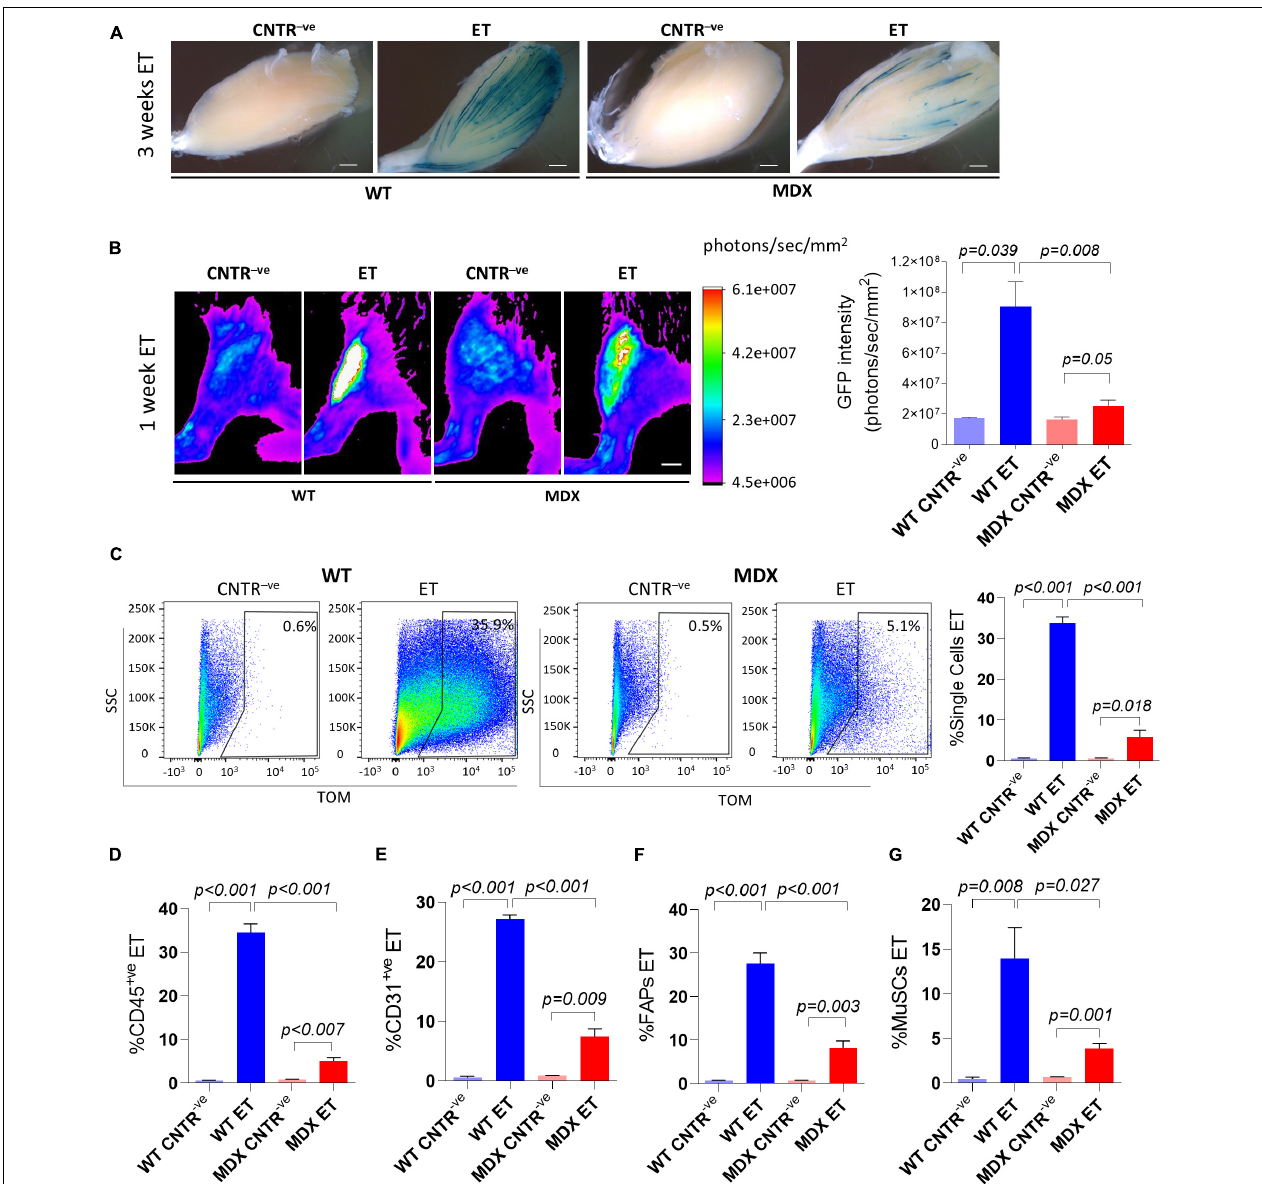
FIGURE 3 | In vivo electroporation of dystrophic muscles. (A) Whole-mount X-gal staining of not electroporated (CNTR – ve ) and electroporated (ET) TA muscles from ∼ 16 months-old C57BL/6J (WT) and mdx 4Cv (MDX) mice. β -gal plasmid was injected in muscles prior electroporation. Muscles were collected 3 weeks after electroporation. N = 2. Scale bar: 0.85 mm. (B) Representative Bruker In Vivo Xtreme I images (left) and GFP intensity measurement (photons/sec/mm 2 ) (right) of TA muscles from 12–14 months-old C57BL/6J (WT) and mdx 4Cv (MDX) mice injected with β -gal (CNTR – ve ) or GFP plasmid (ET) and electroporated. Scale bar: 2.5 mm. White color in the figure indicates photons/sec/mm 2 > 6.1e+007. Muscles were analyzed 1 week after electroporation. N = 2 (WT CNTR – ve ), N = 4 (WT ET; MDX ET), N = 6 (MDX CNTR – ve ). (C) Representative FACS plot (left) and quantification (right) of electroporated (ET, TOM + ve or GFP + ve ) single cells from TA of ∼ 6–9 months-old C57BL/6J (WT) and mdx 4Cv (MDX) mice injected with tdTomato or GFP plasmid and electroporated (ET). CNTR – ve samples are hindlimb untreated muscles or muscles injected with PBS and electroporated. The analysis was performed 1 week after electroporation. N = 4. (D–G) Quantification of electroporated (ET) CD45 + ve cells ( N = 3) (D) , CD31 + ve cells ( N = 3) (E) , FAPs ( N = 4) (F) and MuSCs ( N = 4) (G) from muscles of the same mice as in panel (C) . All CNTR – ve gates were set on control samples. The percentage of ET cells in each CNTR – ve gate was < 1% for all the analyzed cell